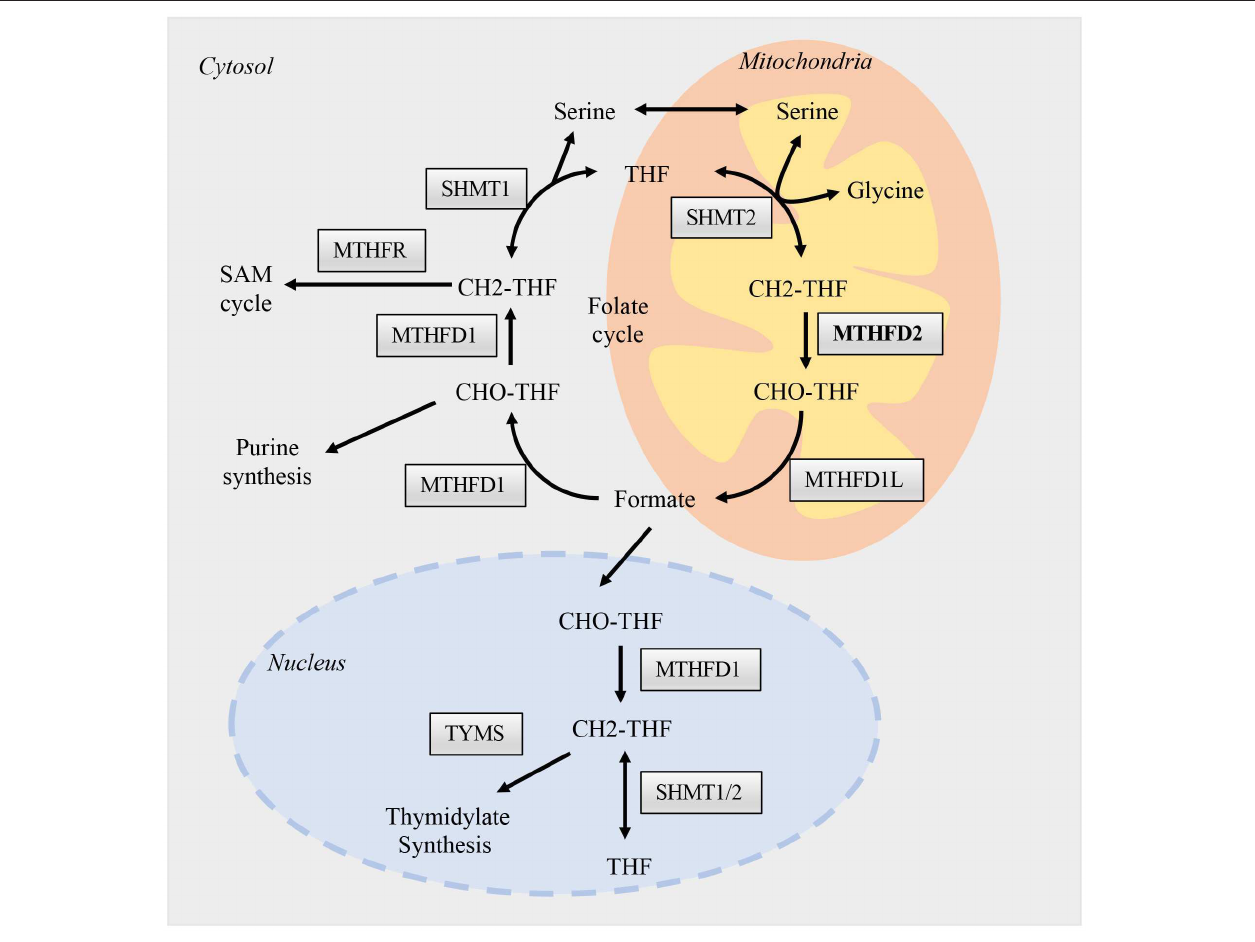
FIGURE 1 | Folate one-carbon metabolism. One carbon metabolism enzymes are presented and activated in three different compartments, the nucleus, cytosol, and mitochondria. The flow of permeable metabolites linked the reactions between these compartments, such as formate, serine, and glycine. Briefly, different forms of THFs, function as carriers, transfer one-carbon units as from serine to formate in the mitochondria. Formate then supply the biosynthesis of purine in the cytosol and thymidylate in the nucleus. The reactions in mitochondria are catalyzed mainly by SHMT2, MTHFD2, and MTHFD1L; while in cytosol and nucleus are by SHMT1/2 and MTHFD1. The enzymatic functions of MTHFD2 in the mitochondria are well-studied, while its role in the nucleus is largely unknown and may hold various non-metabolic